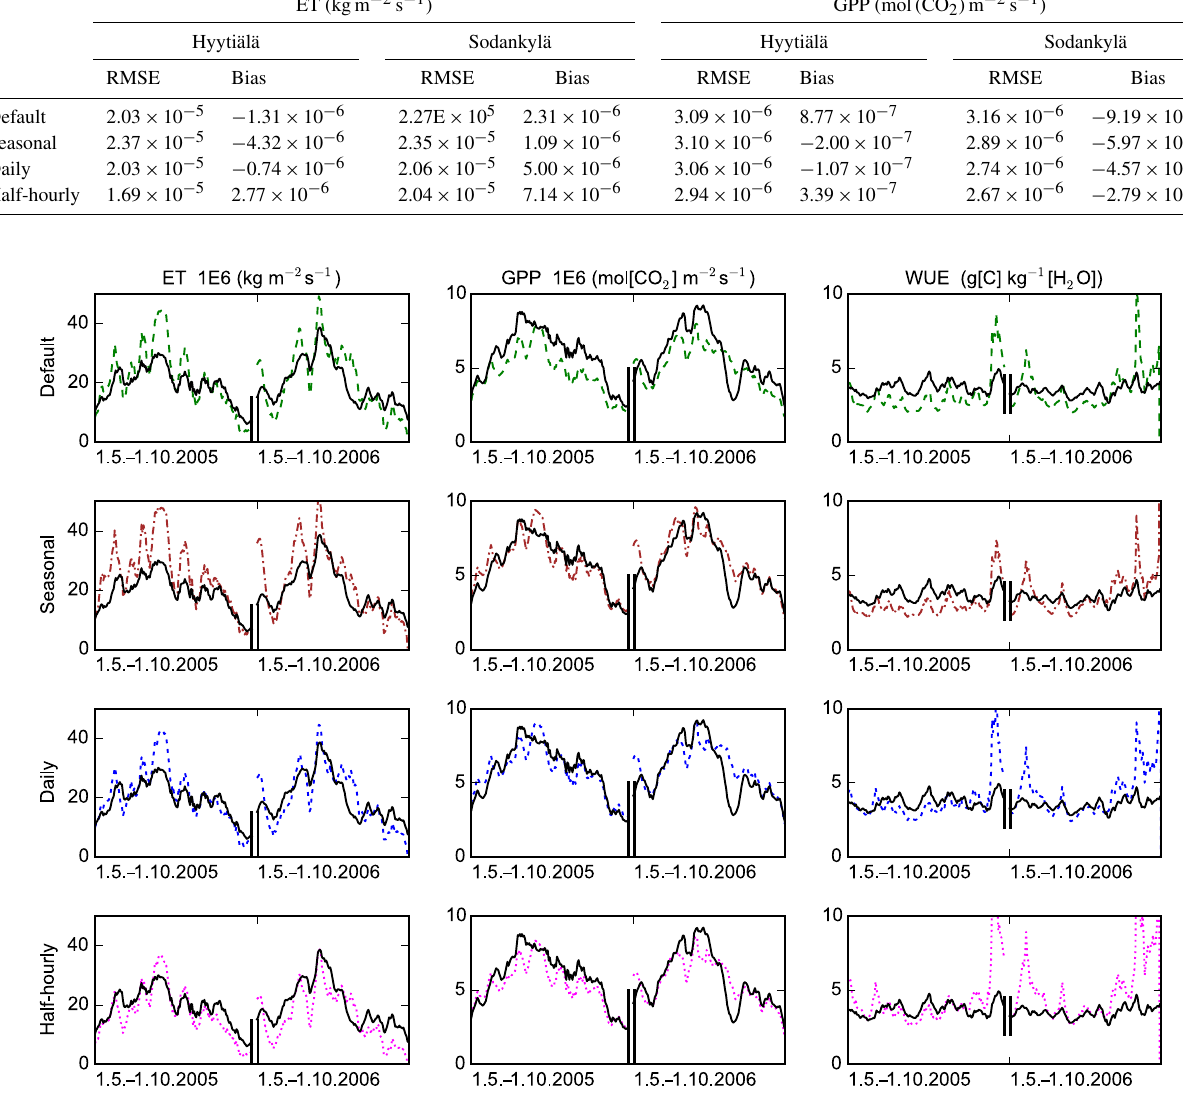
Figure 2. Hyytiälä 7-day-running mean time series for different tunings for the first two summers of the validation period. Solid black line represents the